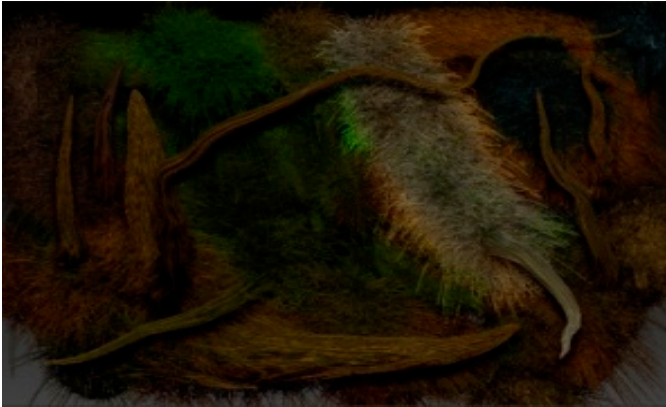
Figure 5. Digital painting. Author: Matteo Romanato.